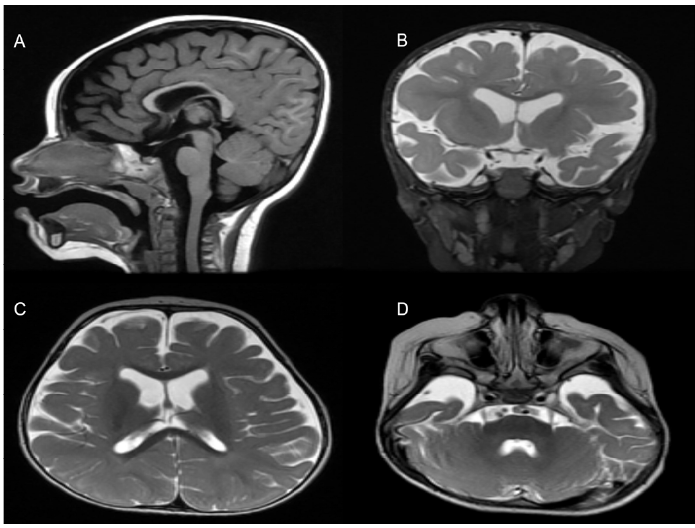
Figure 3. MRI Findings. ( A ) Mild thinning of the corpus callosum. Selected coronal T2 ( B ) and axial T2-weighted images ( C , D ) show volume loss of the cerebral hemispheres with resultant mild expansion of the lateral ventricles and CSF spaces.